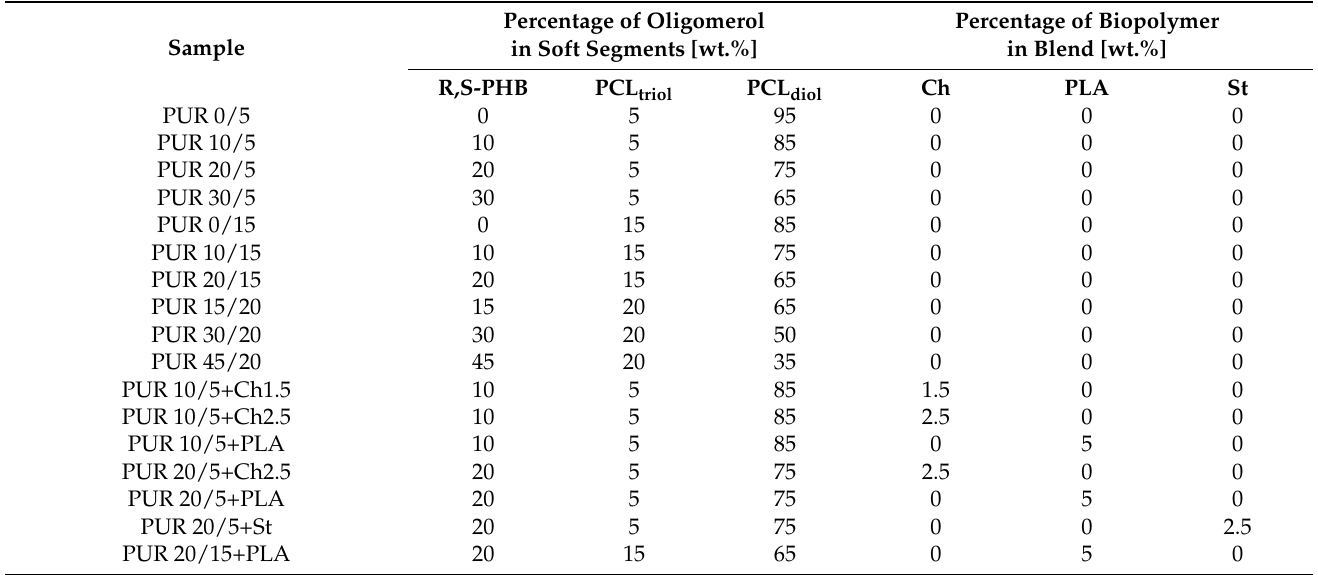
Table 2. Composition of polyurethanes and their